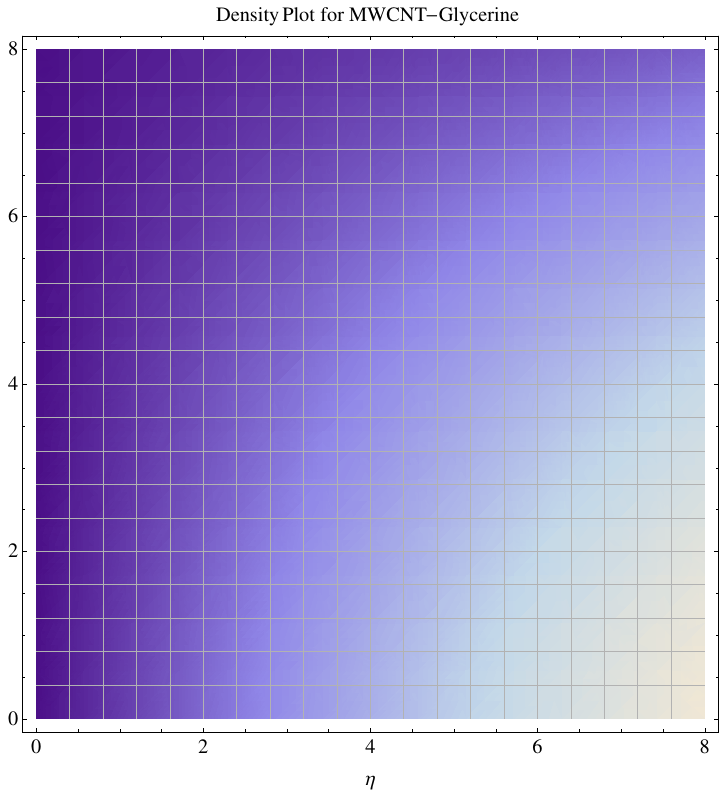
Figure 24. Density graph of multi-walled nanotubes—Glycerine